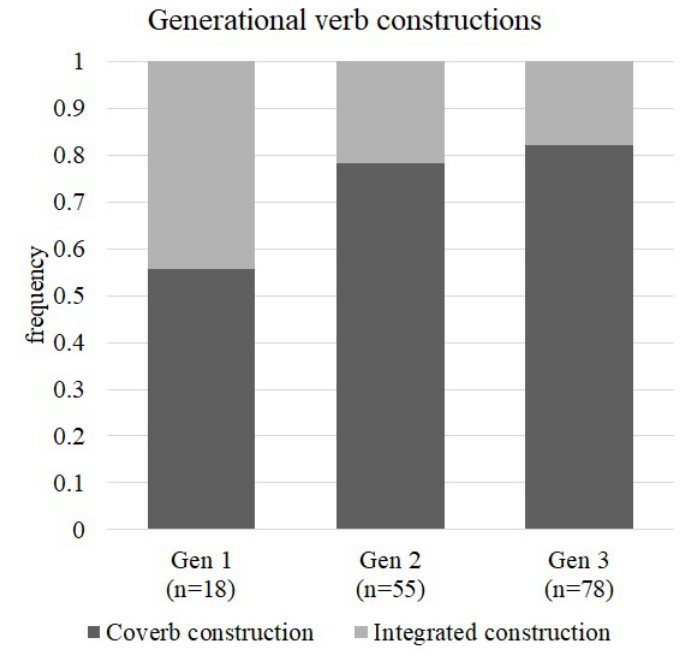
Figure 4. Distribution of coverb strategy and indirect insertion strategy across three